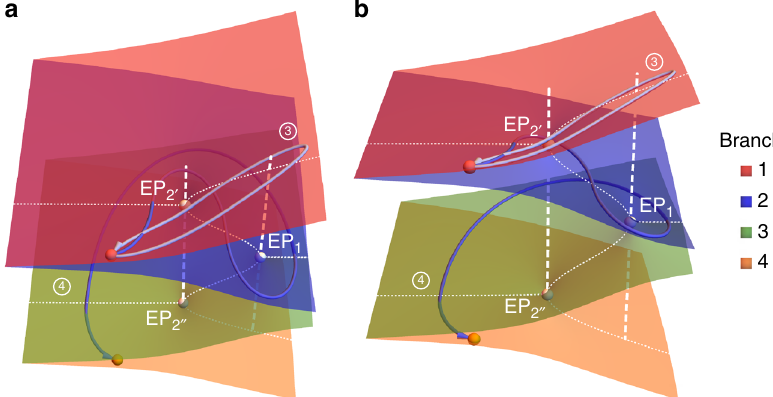
Fig. 6 Riemann surface and homotopy between loops. Two different perspectives for the four-sheet Riemann surface (associated with the real parts of the eigenvalues) that corresponds to Fig. 5d are depicted in a and b . The two loops (cid:5) 3 and (cid:5) 4 (blue lines) that encircle EP 1 (white point) in the two-dimensional (2D) parameter space are also shown. As explained in the text, the homotopy test (performed parameter space) for these two loops shows that they are not equivalent, which results in different stroboscopic and dynamic features. On the Riemann surface, this property becomes even more evident by noting that the two loops span different sheets. The red point stands for eigenvalue λ 1 (corresponding to eigenstate s 1 ) at the initial parameter point. This state will evolve to itself or to the orange point along loops (cid:5) 3 and (cid:5) 4 , respectively. The dashed white lines are vertical lines emanating from the exceptional points (EPs) to illustrate the fact that the projections of the two loops considered here encircle EP 1 but not EP 2 . The white dotted lines illustrate the eigenvalue bifurcation across the EPs on the Riemann surface